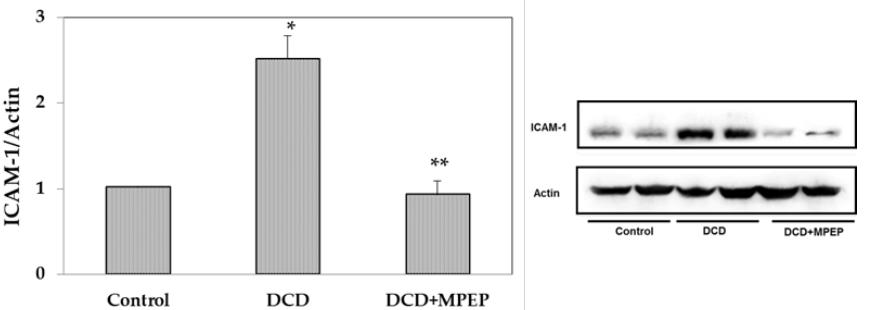
Figure 3. MPEP treatment decreases ICAM-1 in DCD livers during cold storage (22 h in UW solu- tion). Control animals underwent cold storage; in the DCD group, the livers, after 30 min warm ischemia, were submitted to cold storage. In the DCD-MPEP group, the drug (10 mg/Kg) was ad- ministered 30 min before the portal clamping and added to the UW solution (3 µM). The results are reported as the mean ±SE. * p < 0.05 versus control; ** p < 0.05 versus DCD.